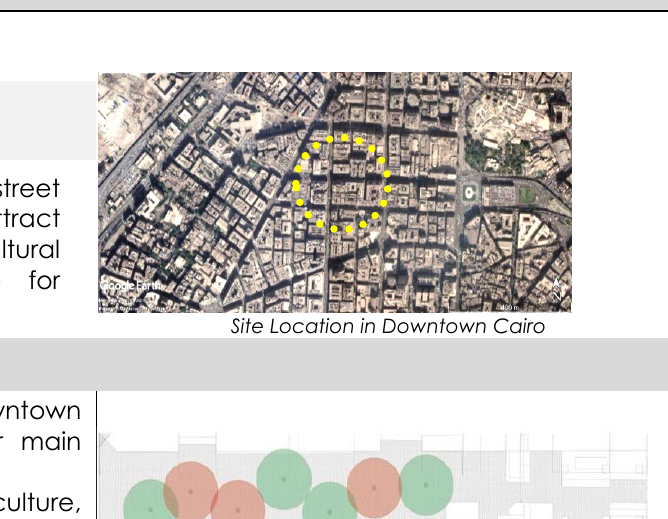
Table 5. Pedestrian streetscape passage in Downtown Cairo. Project